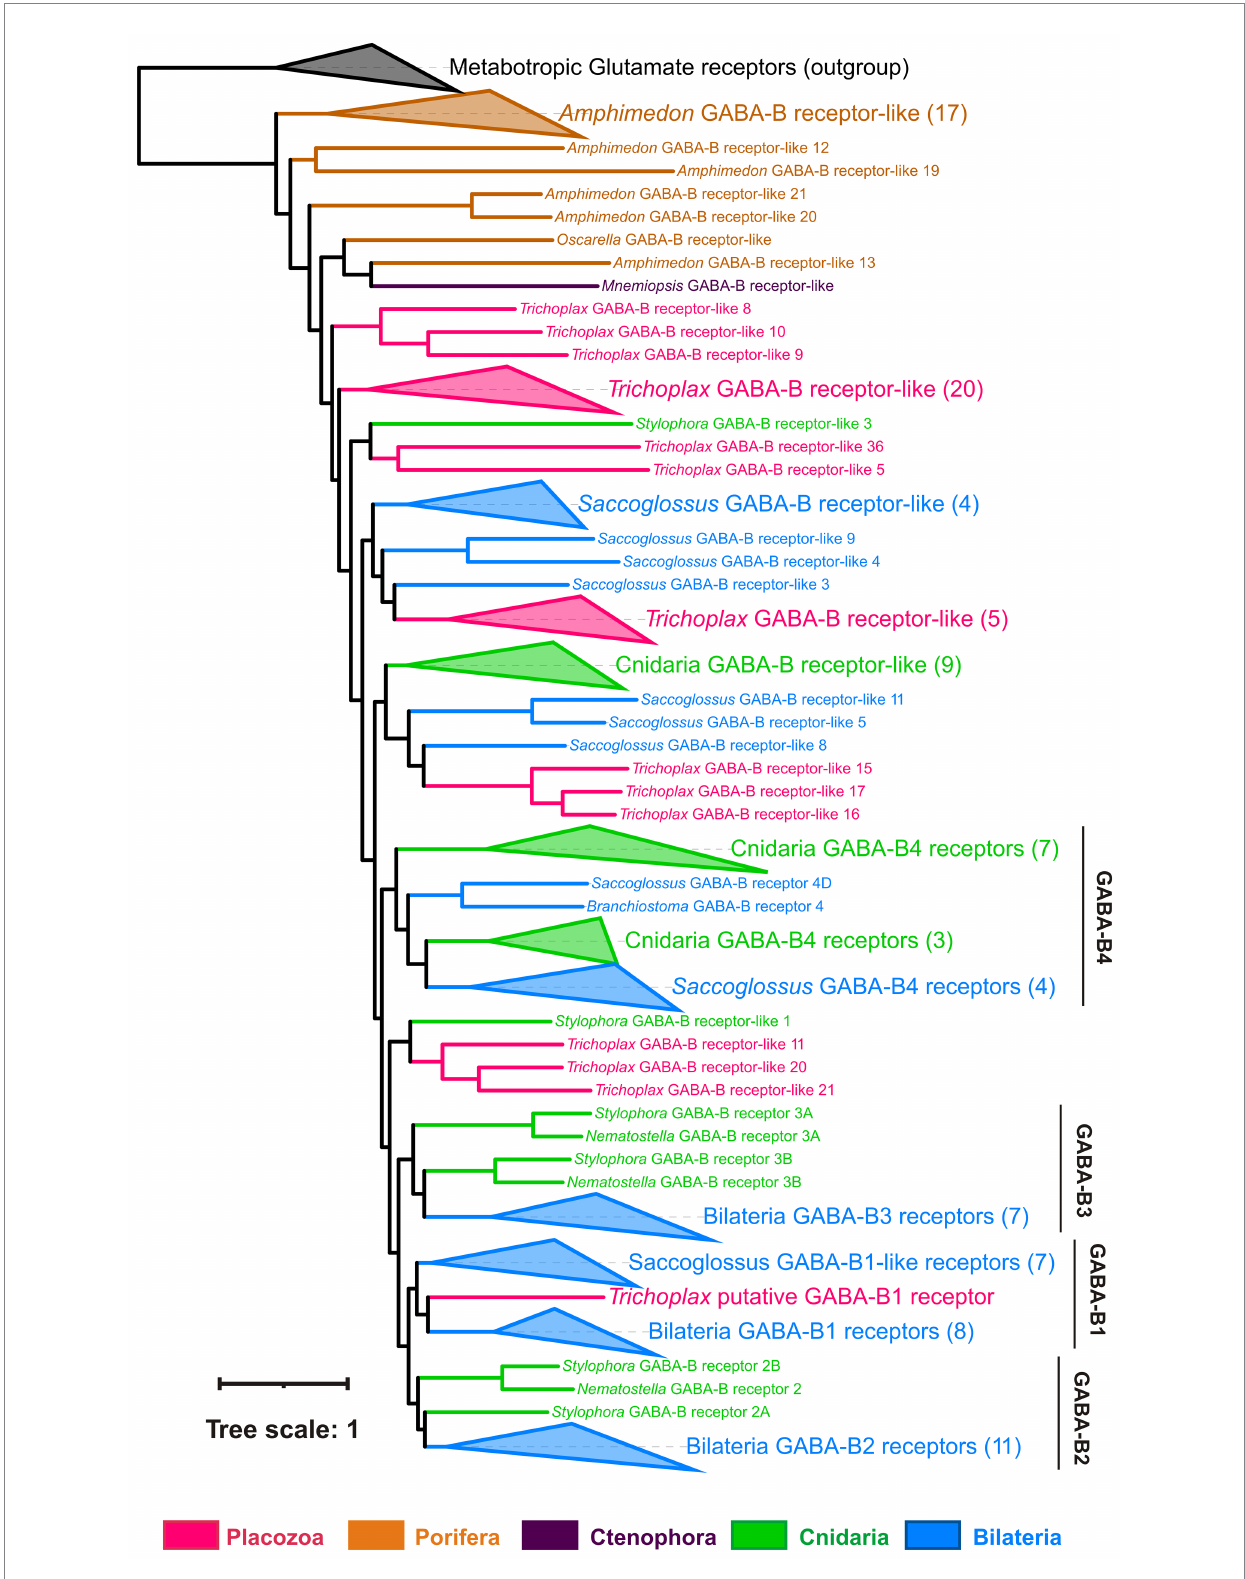
FIGURE 10 Phylogeny of GABA-B-like receptors: Trichoplax has 37 GABA-B-like receptors, more than any other analyzed species (Maximum likelihood phylogenetic tree). One placozoan receptor is orthologous to vertebrate GABA-BR1 and is the first candidate for sensing GABA. Placozoan GABA-B- like receptors form seven separate clades in the tree. Similarly, cnidarians and hemichordate Saccoglossus also have numerous GABA-B-like receptors (16 in Stylophora , 29 in Saccoglossus ), comprising several different clades. This tree structure suggests high diversity of GABA-B-like receptors in basal metazoans and their subsequent loss in many bilaterian lineages. Black dots mark highly supported nodes (bootstrap support > 0.75). Full uncollapsed trees with numeric support values can be found in Supplementary Figure